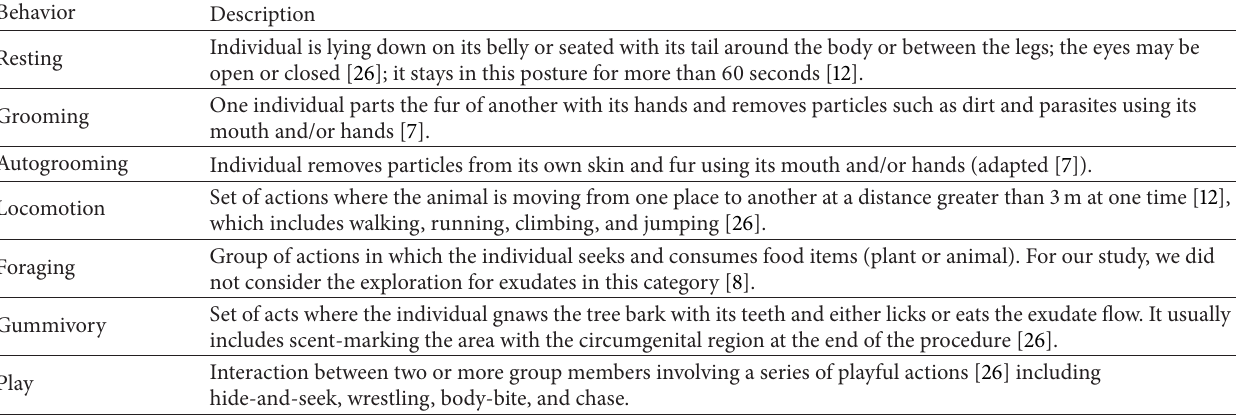
Table 2: Description of the recorded behavioral patterns.